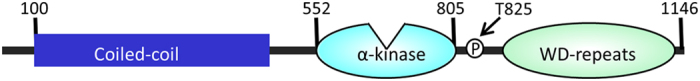
Schematic diagram showing the domain organization of MHCK-A.MHCK-A consists of an N-terminal coiled-coil domain (left), a central α-kinase domain and a C-terminal WD repeat domain (right). The Thr825 site of autophosphorylation required for activity is indicated by a P.